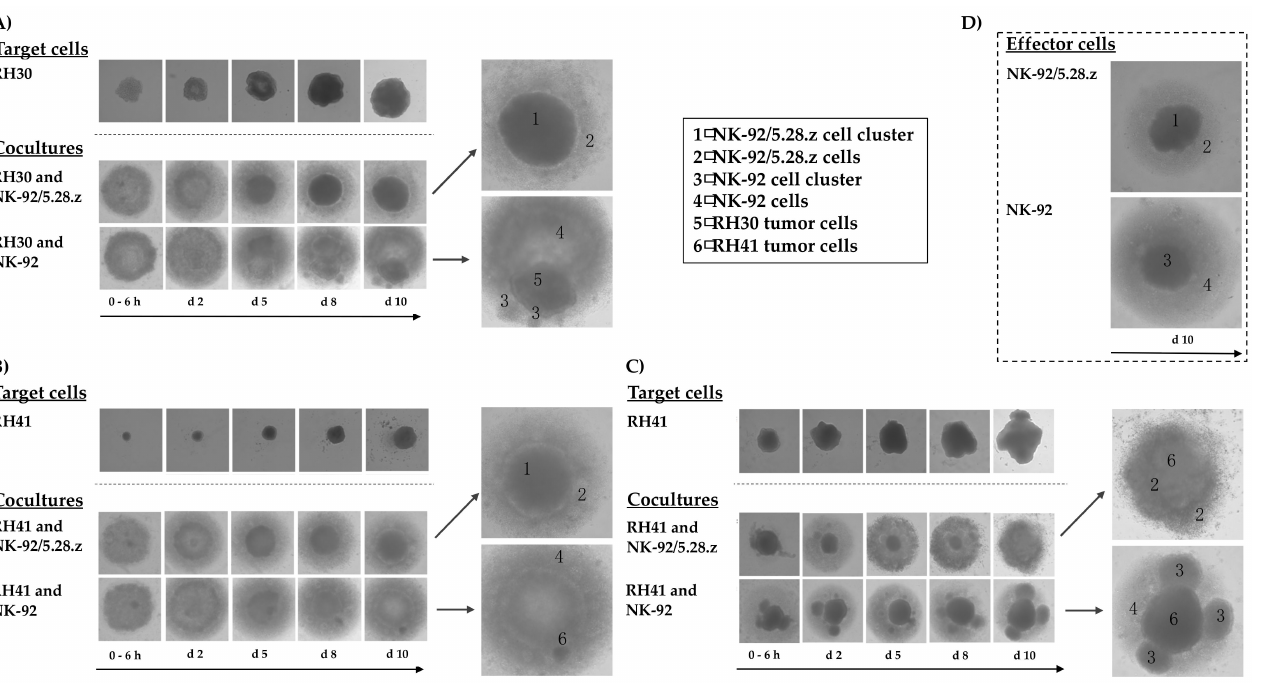
Figure 5. Activity of NK-92/5.28.z cells against aRMS tumor spheroids. Tumor spheroids were established from RH30 ( A ) and RH41 cells ( B , C ). NK-92/5.28.z or NK-92 cells were added as effector cells at an E:T ratio below 1:1, and their growing and antitumoral activity were followed over 10 days. NK-92/5.28.z cells exhibited fast and efficient lysis of aRMS tumor spheroids within two ( A , B ) to five days ( C , fewer effector cells), while parental NK-92 cells were not able to efficiently lyse the tumor cells in 3D culture. Growing behaviors of target and effector cells ( D ) alone as well as in cocultures are shown in parallel, which allows for discrimination between tumor and effector